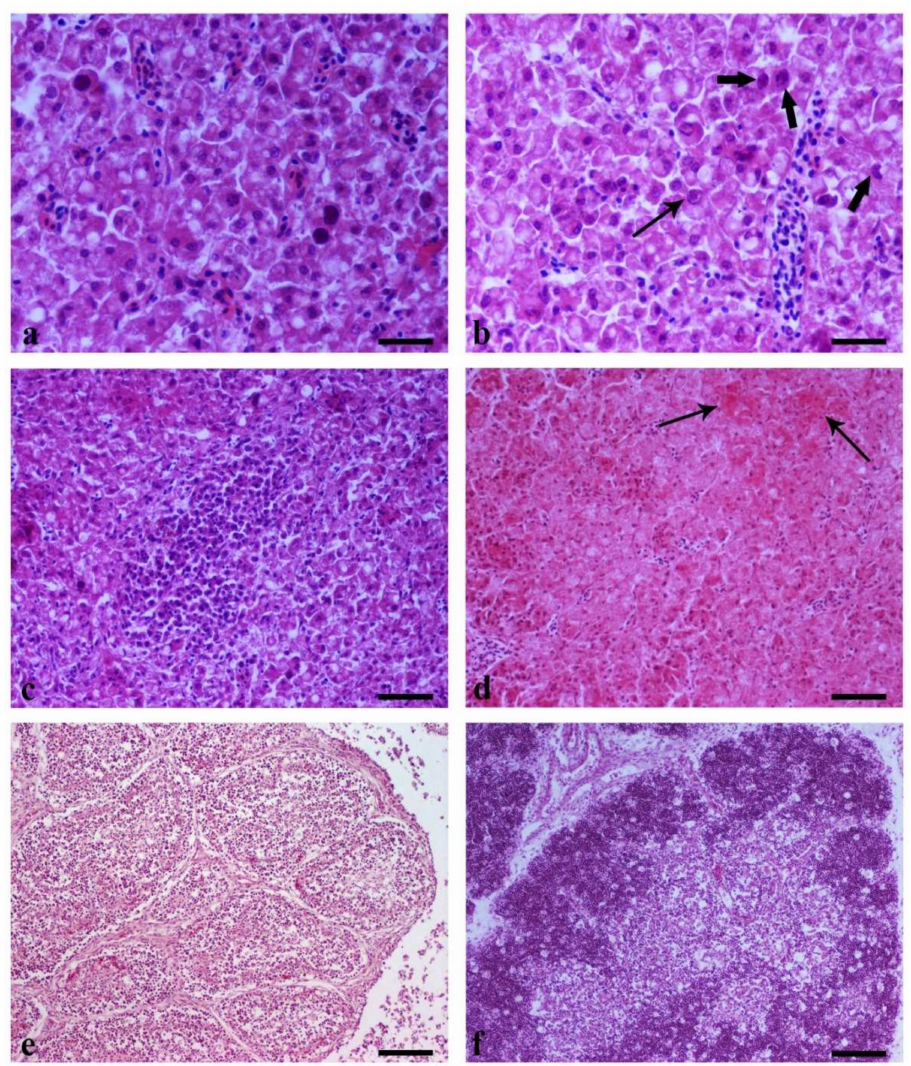
Figure 8. ( a ) Liver. Fatty degeneration and necrosis of hepatocytes and presence of intensely basophilic intranuclear inclusions bodies. H-E. Bar, 25 µ m. ( b ) Liver. Fatty degeneration and necrosis of hepatocytes. Intranuclear inclusion bodies, eosinophilic surrounded by light halo (thin arrow) and basophilic (thick arrows), are obvious. H-E. Bar, 25 µ m. ( c ) Liver. Marked centrally located inflammatory cell infiltration consists of lymphocytes, macrophages, plasmacytes, and heterophils. Hepatocytes show fatty degeneration and/or necrosis as well as basophilic intranuclear inclusions bodies. H–E. Bar, 50 µ m. ( d ) Liver. Hepatocyte vacuolar degeneration is prominent, accompanied by areas of coagulative hepatocellular necrosis (arrows). H–E. Bar, 50 µ m. ( e ) Bursa. Atrophy of lymphoid follicles with intense depletion of lymphocytes both in the cortex and medulla. H–E. Bar, 100 µ m. ( f ) Thymus. Lymphoid depletion is prominent mostly in the cortex of the thymus, and interlobular spaces present mild edema and vascular distention. Note the scattered clear areas located mostly in the cortex, some of which contain small dark nuclei, characteristic of apoptosis in lymphoid organs. H–E. Bar, 100 µ